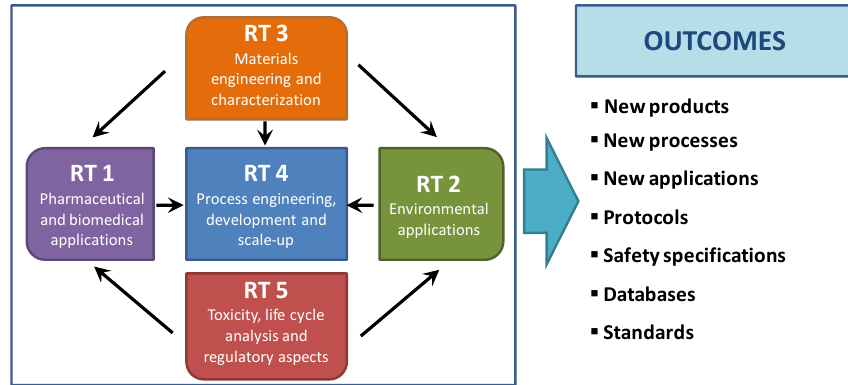
Figure 3. PERT chart for aerogels development in biomedical and environmental applications: research topics (RT, in text boxes), RT-interrelations (in arrows) and expected outcomes (right). Adapted from [31].